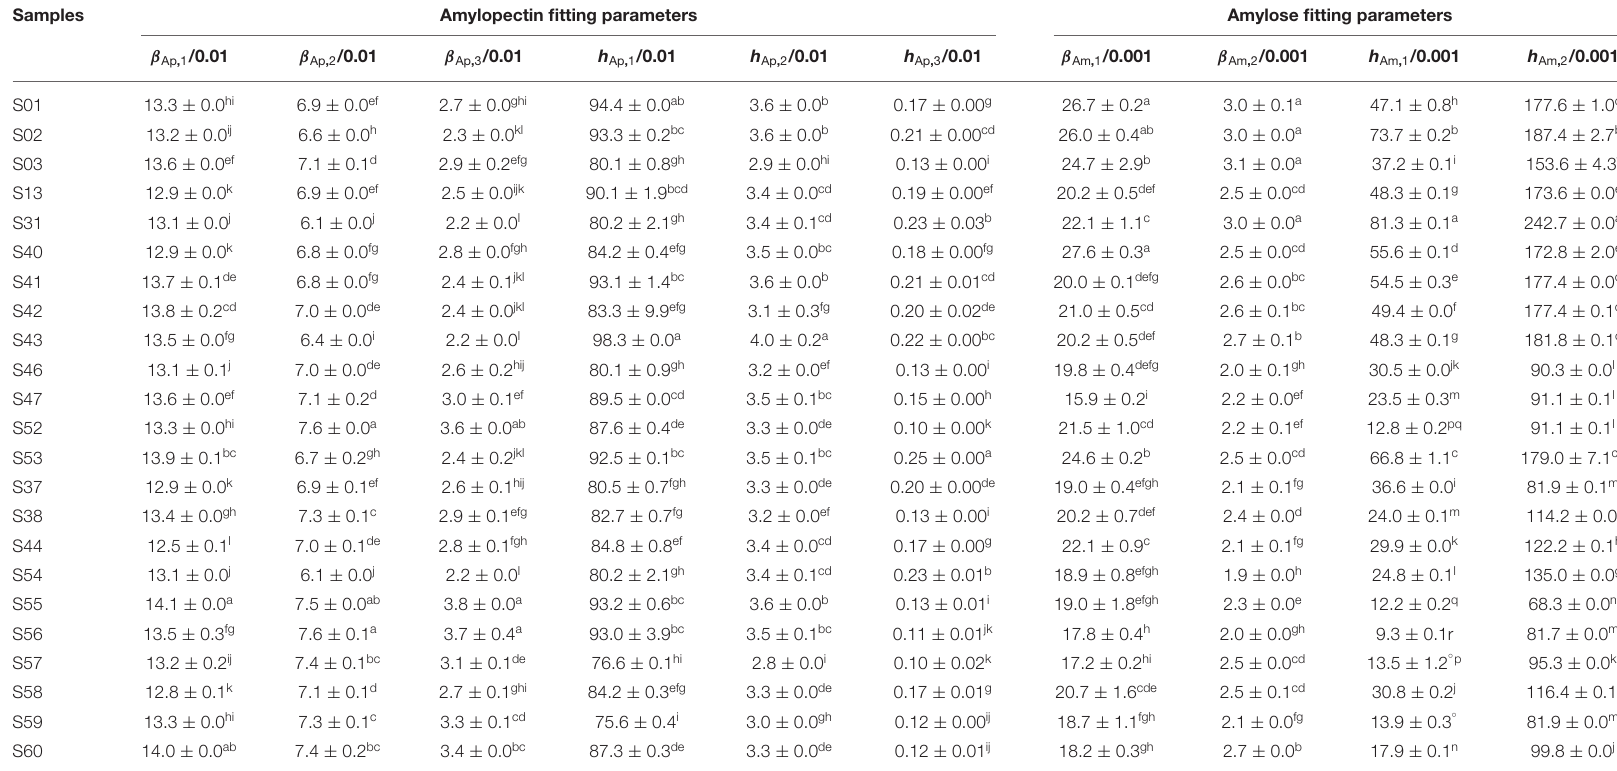
Mean ± standard deviation is calculated from duplicate measurements; values with different letters in the same column are significantly different at p <